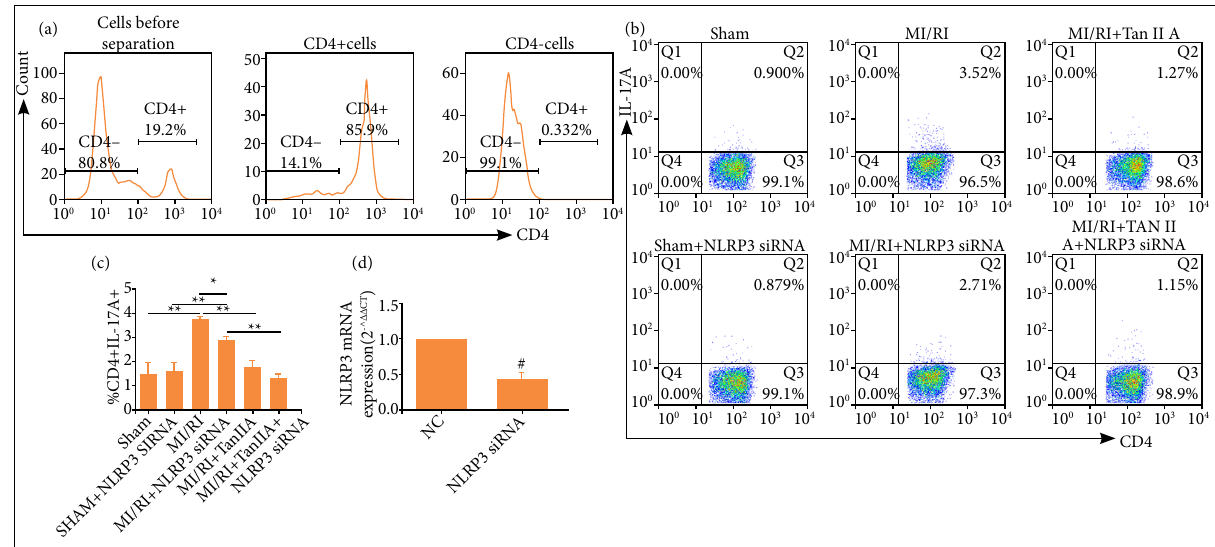
Figure 5 - Inhibition of NLRP3 suppressed Th17 differentiation of CD4+ T cells. (a) Percentages of CD4+ T cells that were isolated by positive selection with MACS CD4 microbeads as shown by FCM. (b) The percentage of Th17 cells was assessed by FACS. (b) Data were expressed as representative FACS images or (c) corresponding statistical graph (n ≥ 3). (d) The mRNA expression of NLRP3 in CD4+ T cells transfected with NLRP3 siRNA or their controls (n ≥